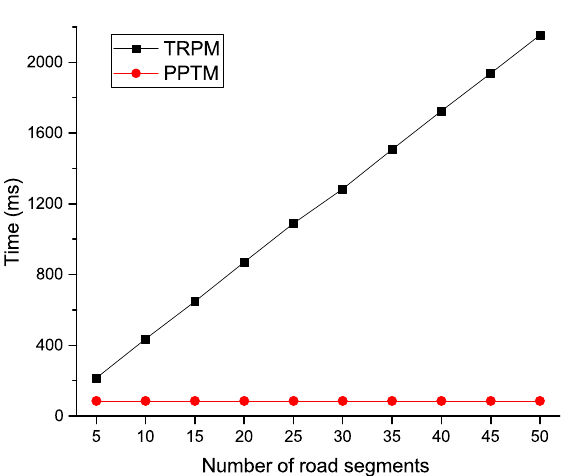
Figure 5. Computational costs of ciphertexts generation at the vehicle side.